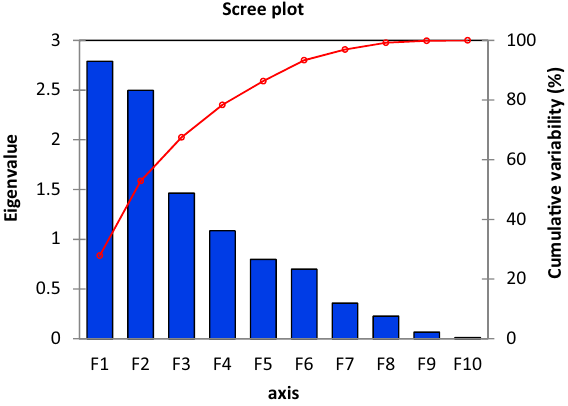
Figure 7. Scree plot of eigenvalue and cumulative variability against the Principal Component Factors.